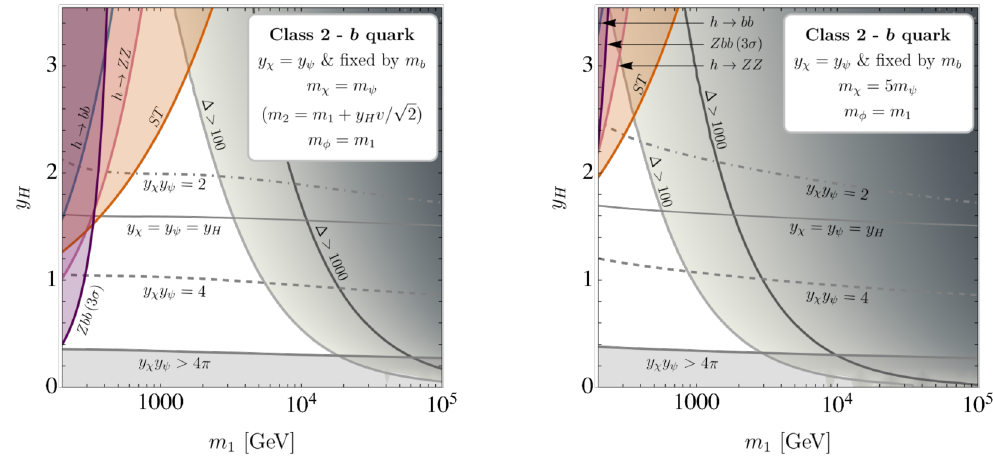
Figure 12. Theoretical (grey) and current 2 σ experimental constraints (coloured) on the Class 2 b -quark benchmark model. The Z ¯ bb constraint is given at 3 σ since there is a & 2 σ tension in the current electroweak fit.